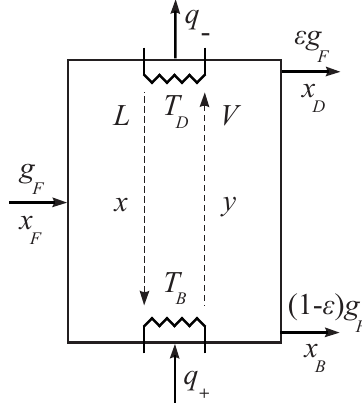
Figure 1. Schematics of a binary distillation